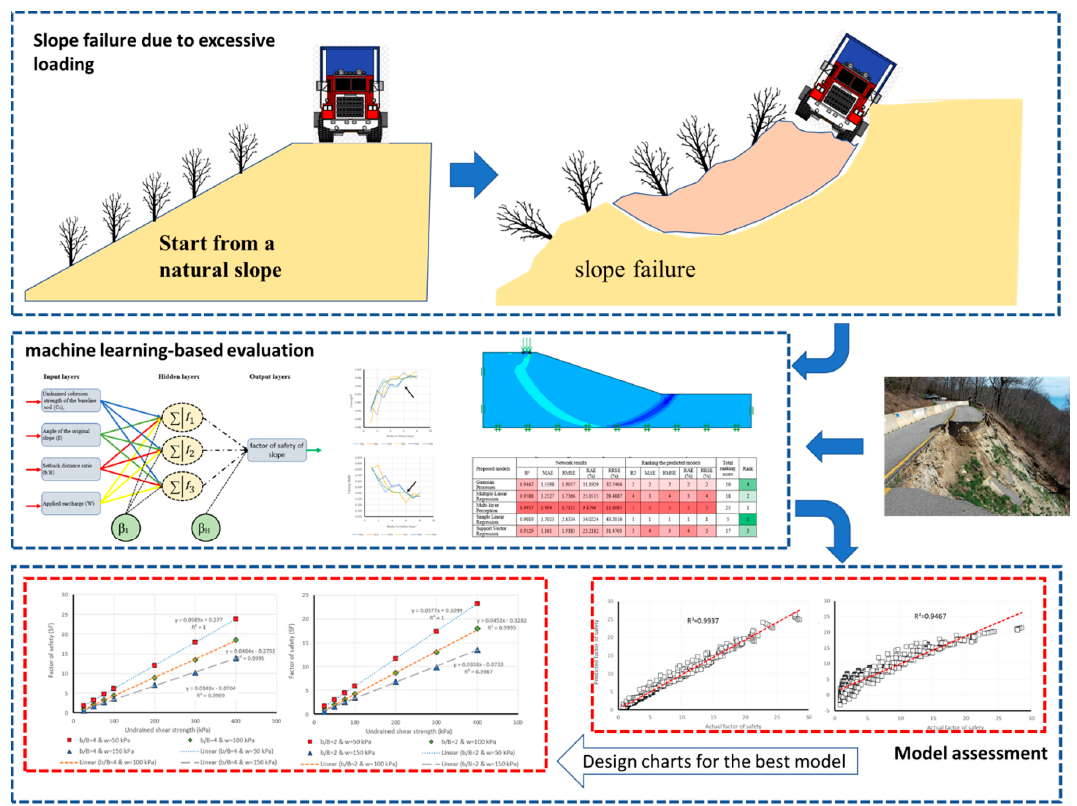
Figure 4. Scheme of development of the database and selected methodology.